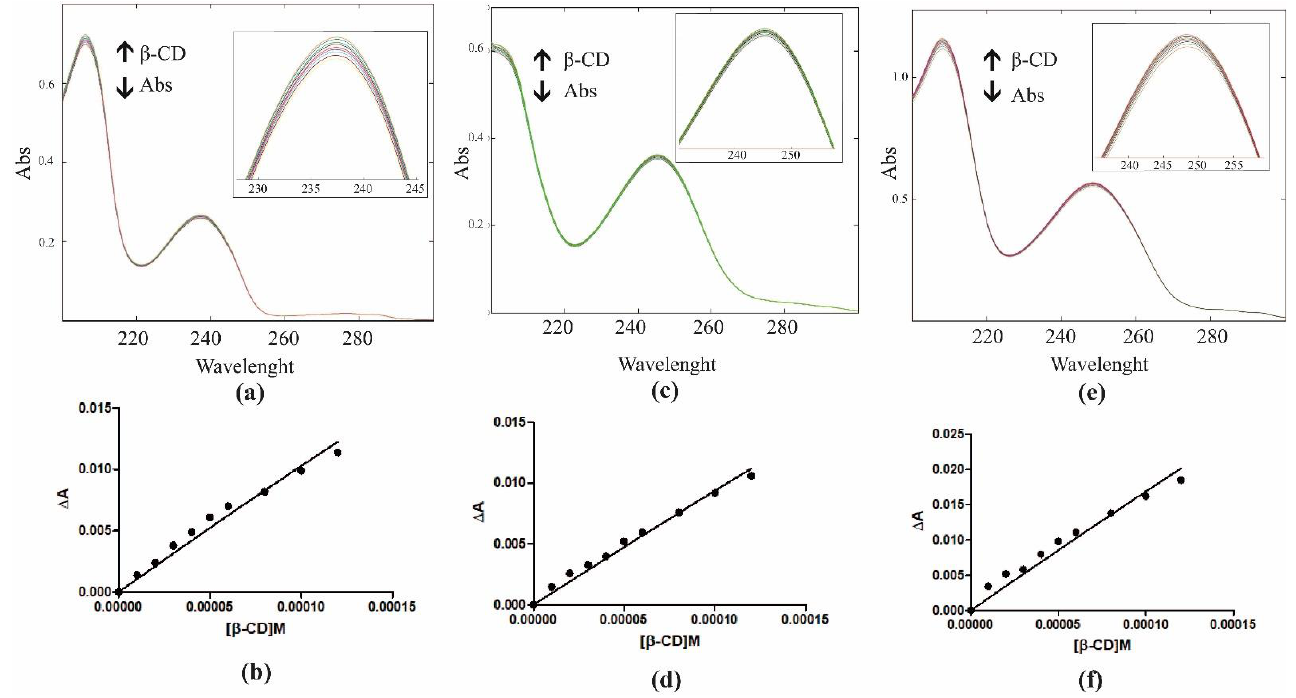
Figure 3. UV-Vis characterization: dependence of chlorpropham ( a ), monuron ( c ), and propanil ( e ) absorbance (Abs) with increasing concentration of β -CD at pH 7.1. The binding constants of β -CD with chlorpropham ( b ), monuron ( d ), and propanil ( f ) were determined by fitting data according to the equation reported in Materials and Methods. Table 1. The binding constant of Pesticide- β Cyclodextrin complexes evaluated by absorbance measurements and relative R 2 .